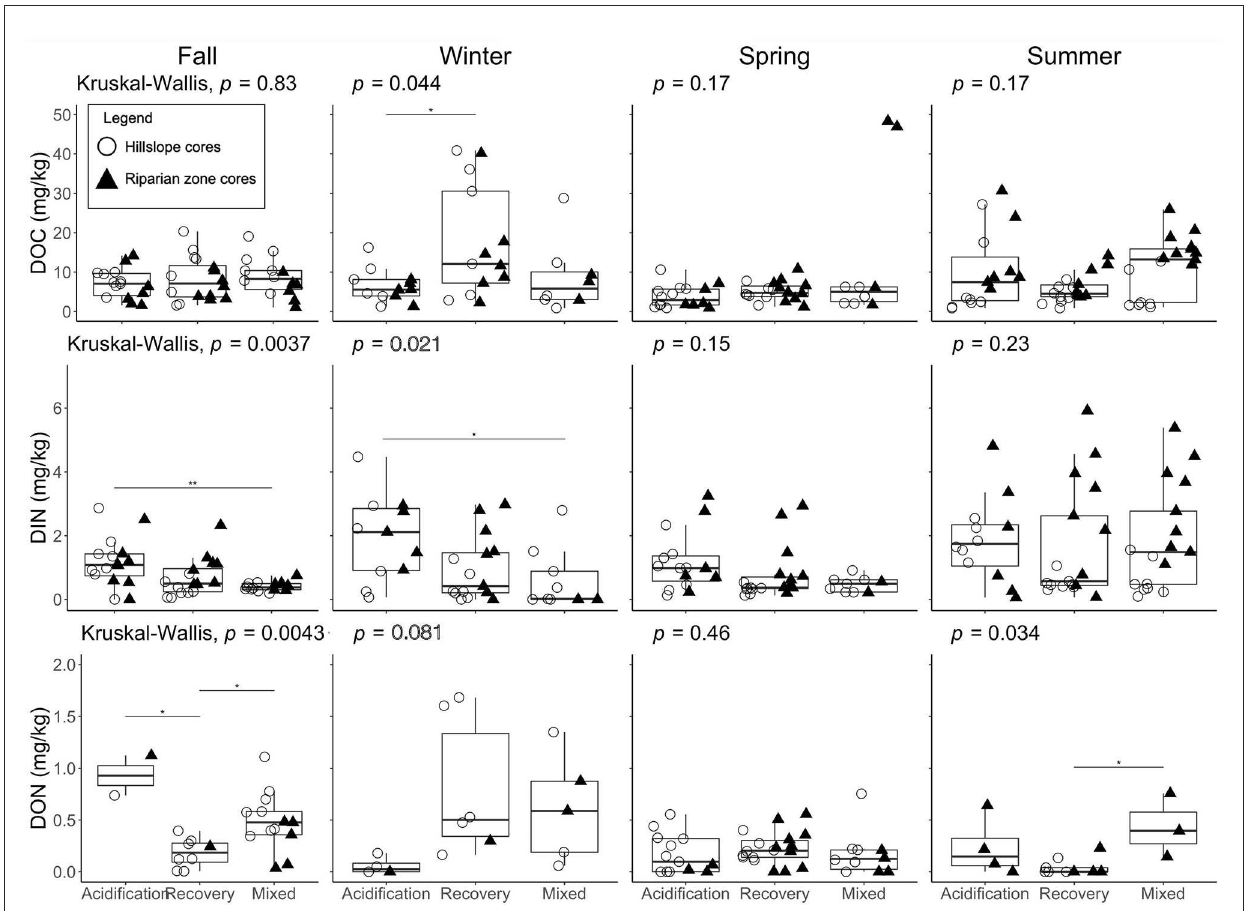
FIGURE4 Seasonal (left to right) dissolved organic carbon (DOC), dissolved inorganic nitrogen (DIN), and dissolved organic nitrogen (DON) concentrations (top to bottom) from soil core leaching experiments. Boxplots are ordered by soil core treatment. Kruskal Wallis tests were used to determine statistically significant ( p ≤ 0.05) differences in means between each treatment. A post-hoc Dunn test with a Bonferroni correction was applied to seasons with a significant Kruskal Wallis p -value. Brackets indicate between which treatments were significant, and asterisks denote significance of treatments as follows: * p ≤ 0.05, ** p ≤ 0.01. Symbols represent the landscape position where the core was collected; open circles represent hillslopes; and solid triangles represent riparian zones. Box plots depict the minimum, first quartile, median, third quartile, and maximum, with outliers depicted as single